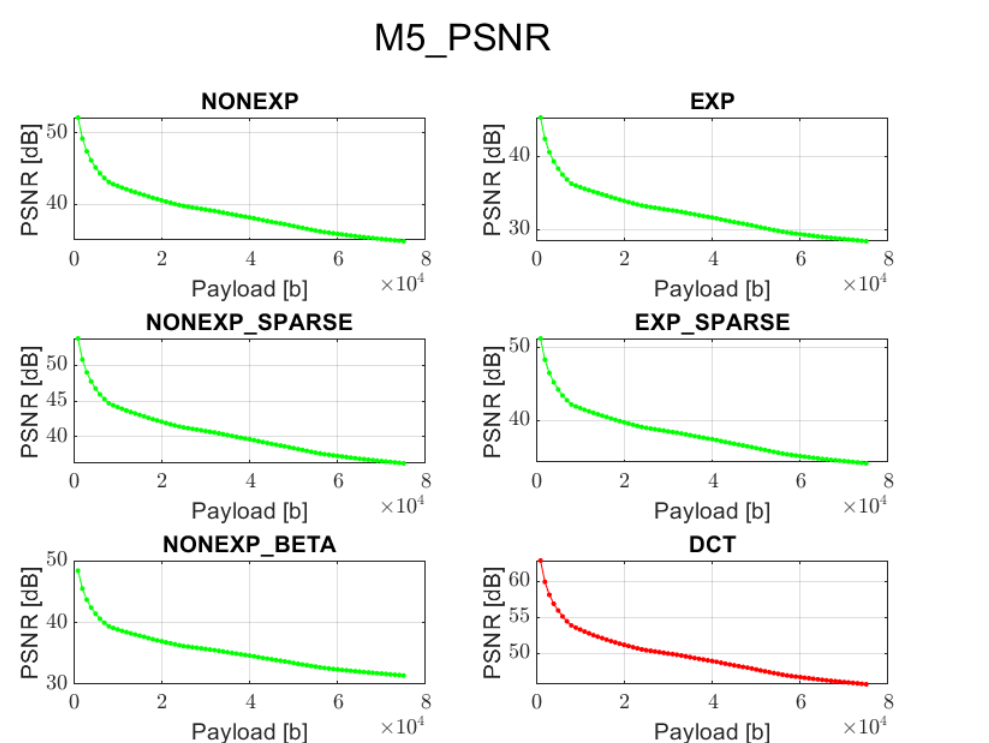
Figure 6. Relation between PSNR and embedded data size for method 5 and all transform types.